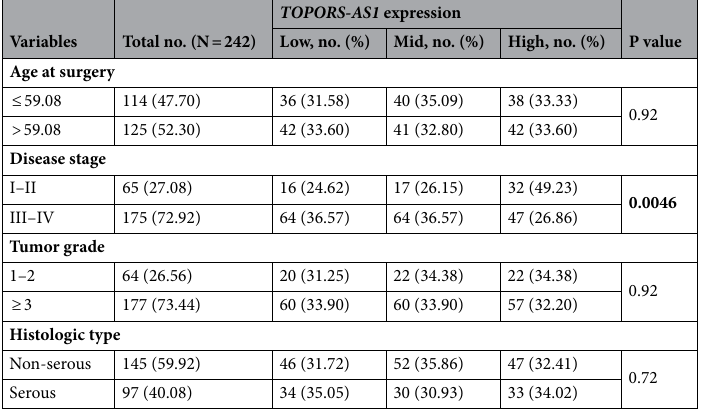
Variable Low Mid